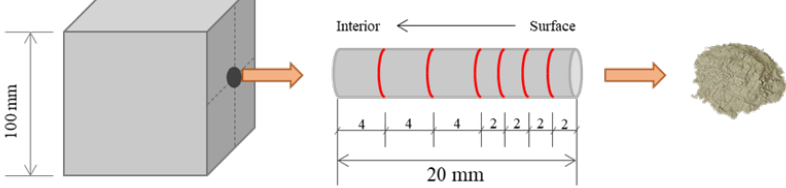
Figure 2. Compressive test of the cubic specimens.